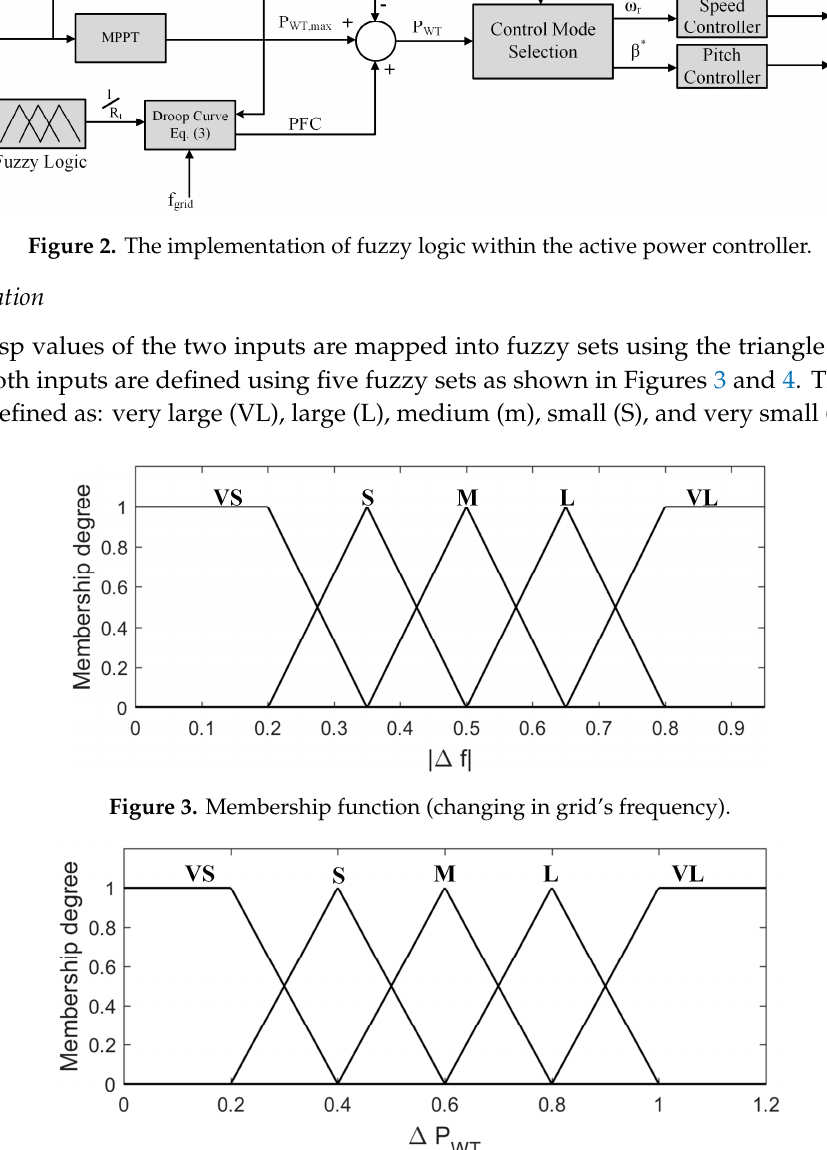
Figure 2. The implementation of fuzzy logic within the active power controller.